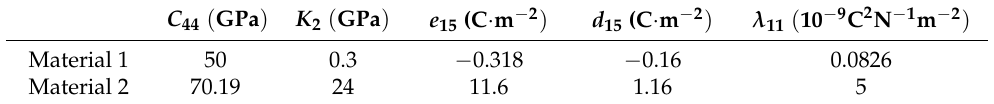
Table 1. Material properties of two 1D hexagonal piezoelectric QCs. C 44 ( GPa